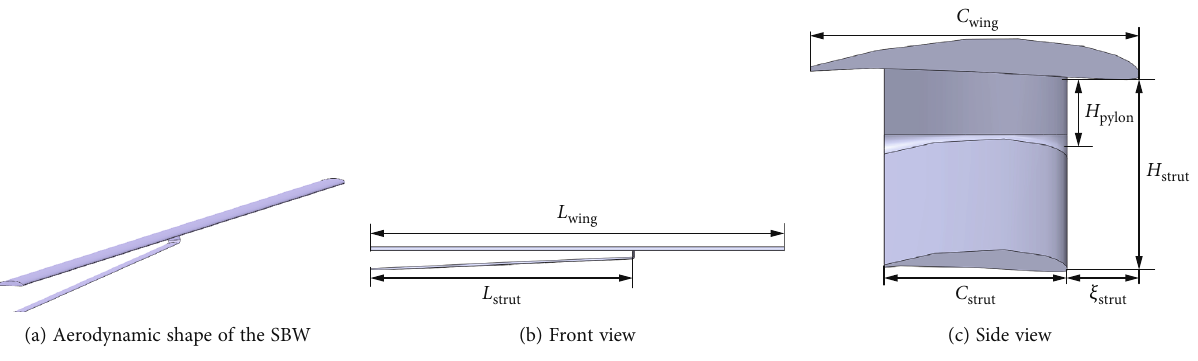
Figure 4: Aerodynamic design parameters.